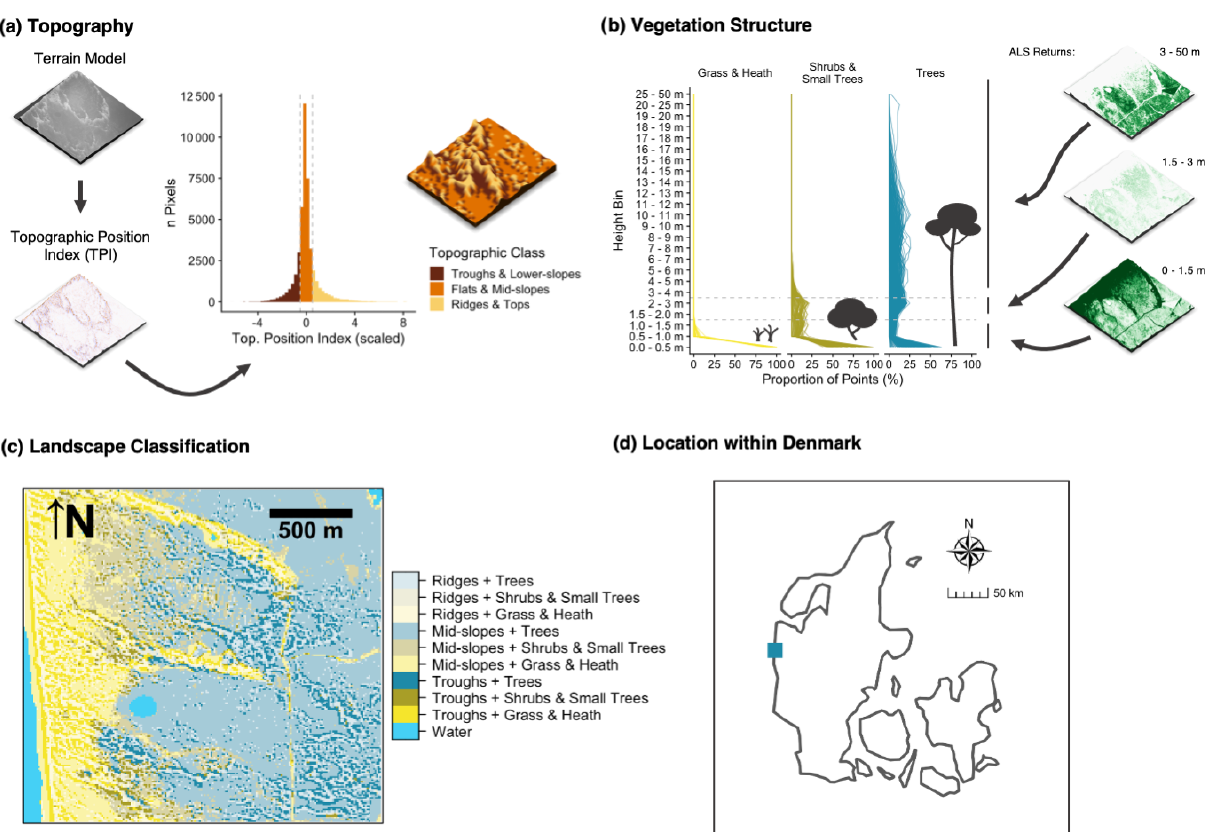
Figure 7. Use-case example: landscape stratification of the Husby Klit protected area based on EcoDes-DK15-derived terrain and vegetation structure descriptors. The target was to stratify the landscape of the Husby Klit “dune plantation” area in the west of Denmark (56.2837– 56.3024 ◦ N, 8.1239–8.1600 ◦ E) to facilitate stratified random sampling for vegetation monitoring. We identified the four tiles overlapping with the boundaries of the protected area and derived a stratification based on two components: topographic position (a) and vegetation struc- ture (b) . We hypothesised that both components would influence the vegetation communities present. For the topographic position (a) , we first derived and standardised the topographic position index (TPI) (Weiss, 2001) from the terrain model (dtm_10m). Following Weiss (2001) we then classified each cell based on the scaled TPI into three categories. A scaled TPI below a value of − 0 . 5 was classified as a “trough or lower-slope”, a scaled TPI between − 0 . 5 and 0.5 as “mid-slope or flat”, and a scaled TPI above 0.5 as a “ridge or top”. For the vegetation structure component (b) , we calculated the proportion of returns in three simplified height bins: (1) 0 to 1.5m, (2) 1.5 to 3.0m and (3) 3.0 to 50m. Here we included both ground and vegetation returns as the divisor for the standardisation but not the returns from buildings or wa- ter. Based on a priori knowledge we deduced that there are three dominant vegetation communities within the protected area: communities dominated by grass and heath with vegetation growth generally below 1.5m, communities dominated by shrubs and small trees (including the invasive Pinus mugo ) with vegetation growth predominantly below 3.0m, and communities dominated by trees (including the native Pinus sylvestris ), generally with growth above 3.0m. We used this knowledge to assign the three vegetation classes based on the proportion of point returns in the simplified height bins. For the “grass and heath” class we used a strict cut-off with no points present above 1.5m. For the “shrubs and small trees” class we used a fuzzy cut-off allowing the proportion of points in the 3.0m and above bin to reach up to 10% of the maximum proportion found in this height bin. All remaining cells were then assigned to the “trees” class. Finally, we combined the two classifications into one as illustrated in (c) . Panel (d) shows the location of the protected area within Denmark. The three-dimensional raster visualisations were generated using the rayshader v0.19.2 package in R (Morgan-Wall,